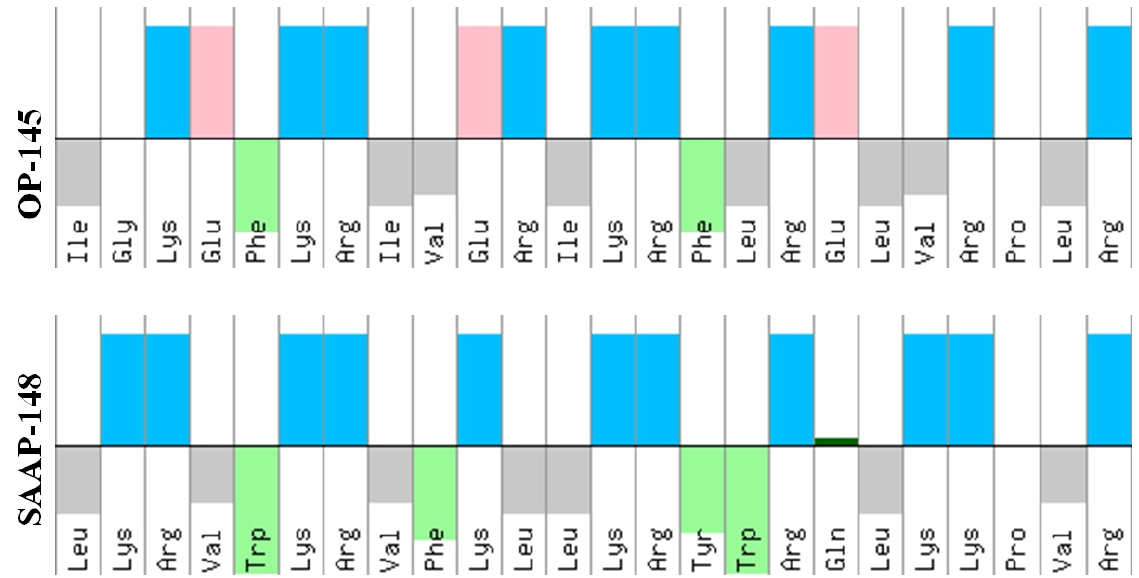
Figure 1. Peptide sequences. Distribution of amino acid residues in OP-145 and SAAP-148. Both peptides are N-terminally acetylated and C-terminally amidated, which is not shown in the pictures above. The hydrophilic residues are shown on top and hydrophobic on bottom as illustrated by Peptide Property Calculator (https://pepcalc.com/, accessed on 1 May 2022). Color code: acidic (red), aromatic (green), cationic (blue), aliphatic (grey), and polar (dark green).